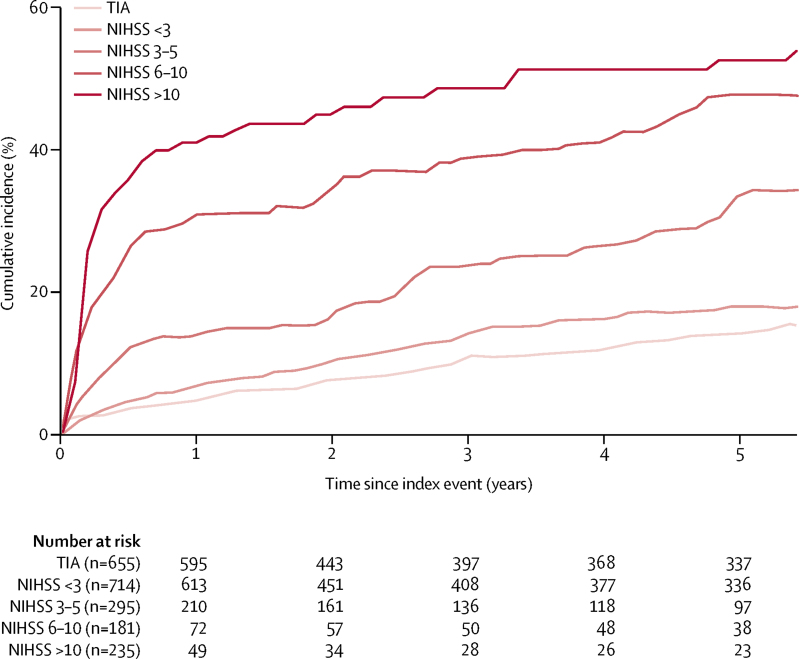
Kaplan-Meier curves of cumulative incidence of post-event dementia up to 5-years' follow-up, stratified by event severityThe event is the index transient ischaemic attack or stroke. Patients with and without previous stroke were included, but those with pre-event dementia were excluded. TIA=transient ischaemic attack. NIHSS=US National Institutes of Health Stroke Scale.